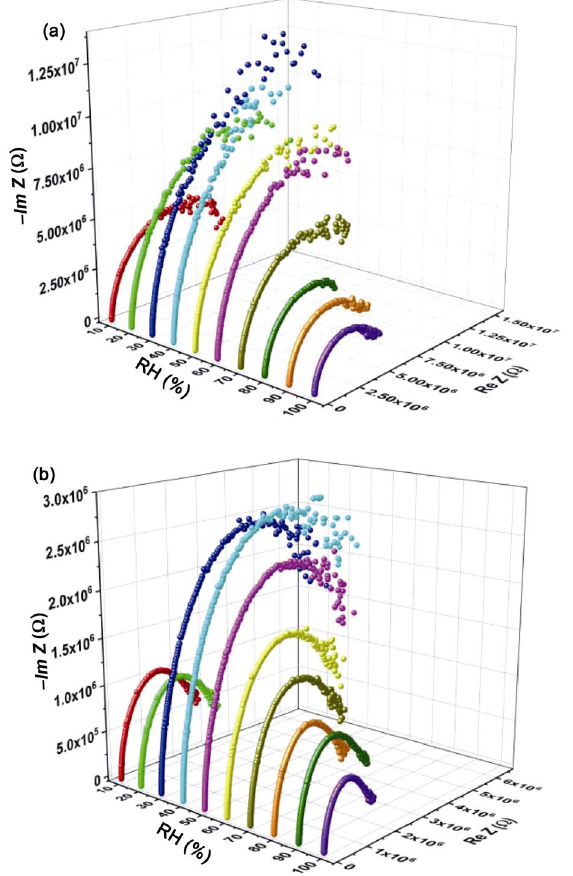
Fig. 5 Nyquist diagrams of the TiO 2 /WO 3 systems as function of RH, at 20 ℃ : (a) 500 ℃ , 1 layer; (b) 500 ℃ , 3 layers.